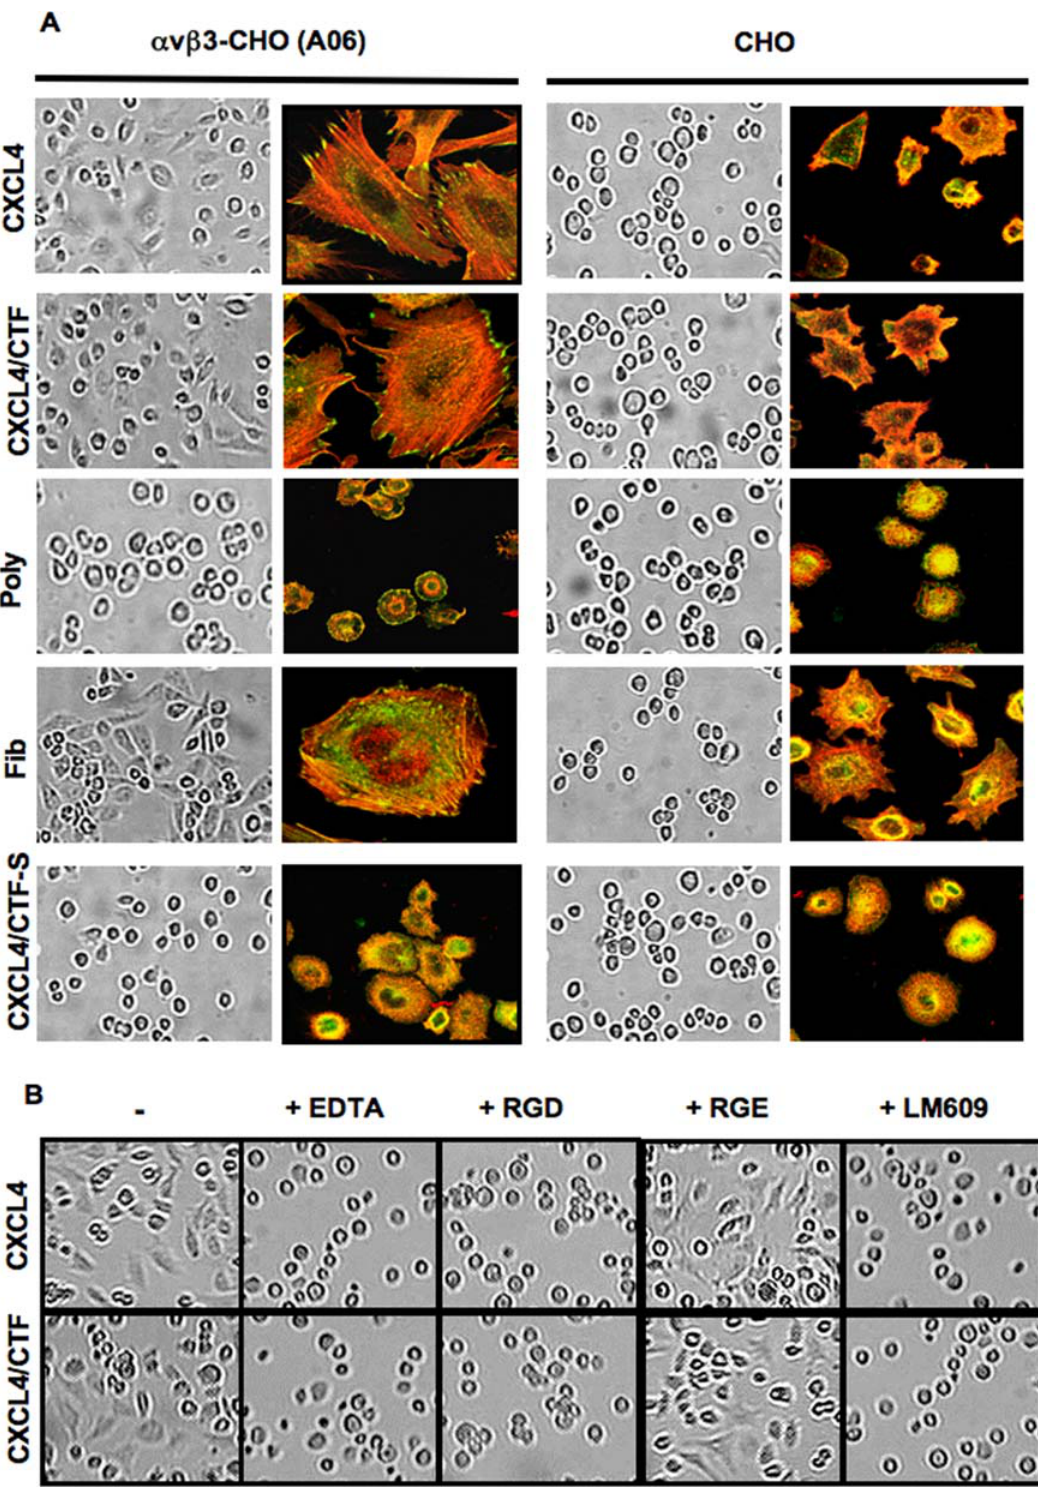
Figure 4. Immobilized CXCL4 or CXCL4/CTF promotes a v b 3-CHO cell spreading, focal adhesion and stress fiber formation. A. a v b 3- CHO and mock-transfected CHO cells were plated for 4 h on coverslips that had been coated with (25 m g/ml) CXCL4, (25 m g/ml) CXCL4/CTF, (25 m g/ ml) CXCL4/CTF-S, (100 m g/ml) fibrinogen and (100 m g/ml) poly-D-lysine. After washing, the cells are fixed. The degree of cell spreading is seen from the phase contrast micrographs (left side). Then the cells were permeabilized and stained to visualize focal adhesion (vinculin staining, green), and actin stress fibers (Rhodamin-Phalloidin staining, red) by confocal microscopy (right side). B. Effects of function-blocking anti-integrin antibodies and EDTA and RGD-, RGE-peptides on cell spreading to CXCL4 or CXCL4/CTF. a v b 3-CHO cells were incubated with 10 mM EDTA or 25 m g/ml of RGD- or RGE-peptides or 10 m g/ml anti- a v b 3 (LM609), before plating to coverslips coated with (25 m g/ml) CXCL4 or (25 m g/ml) CXCL4/CTF for 3 h at 37 u C. Wells were washed with PBS, and cells were